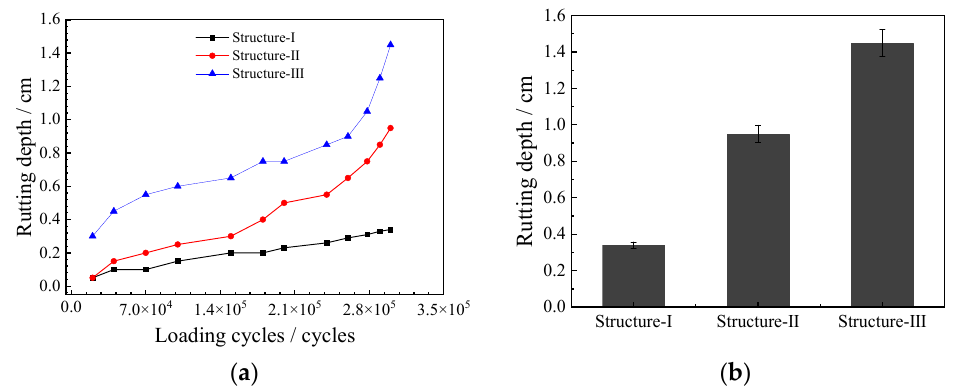
Figure 9. Rutting depth of the three composite specimens. ( a ) Rutting depth development curves. ( b ) Rutting depth after accelerated loading tests.